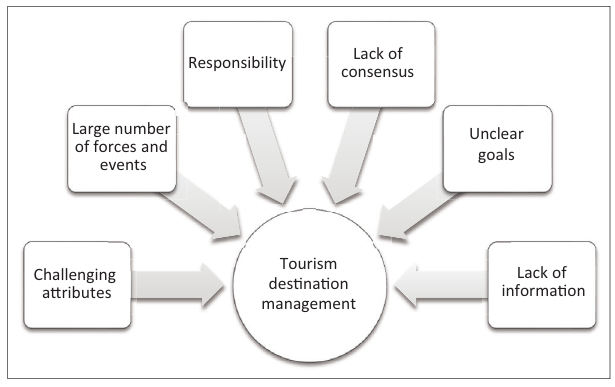
FIGURE 1: Complexity of destination management.